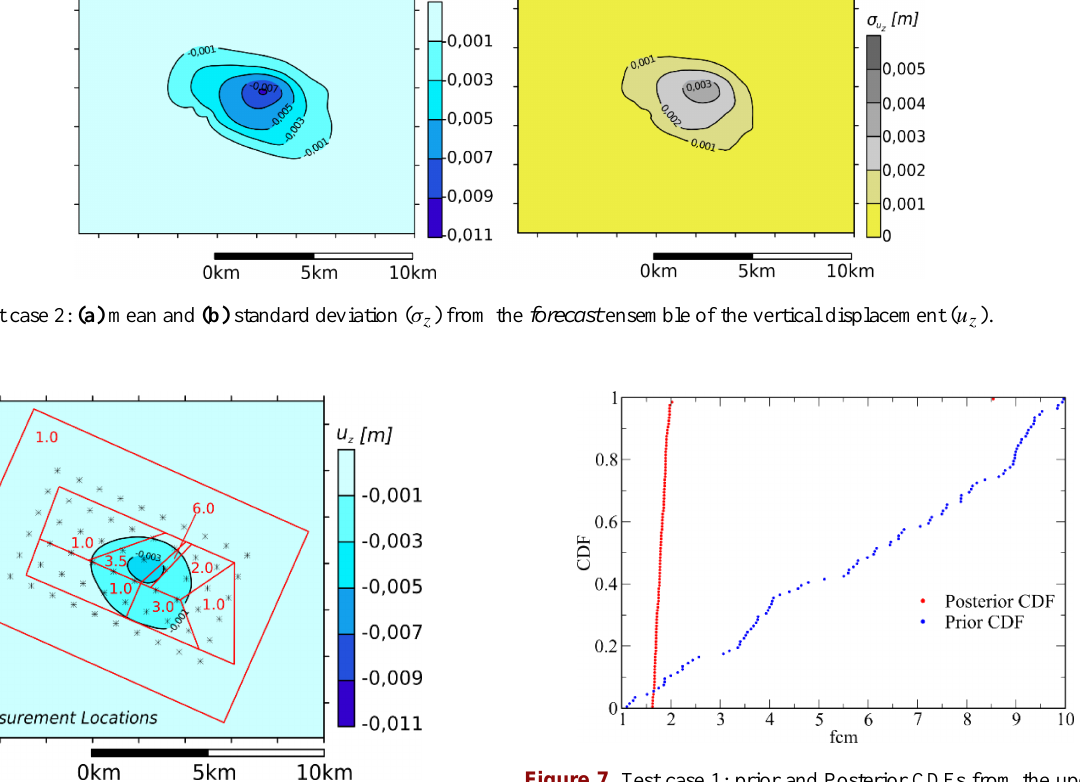
Figure 6. Spatial distribution of the synthetic land subsidence data ( u z ). Assimilation data are collected at the 60 measurement loca- tions displayed in the map. The red lines represent the trace of the faults subdividing the reservoir into blocks with the prescribed ref- erence f CM values.